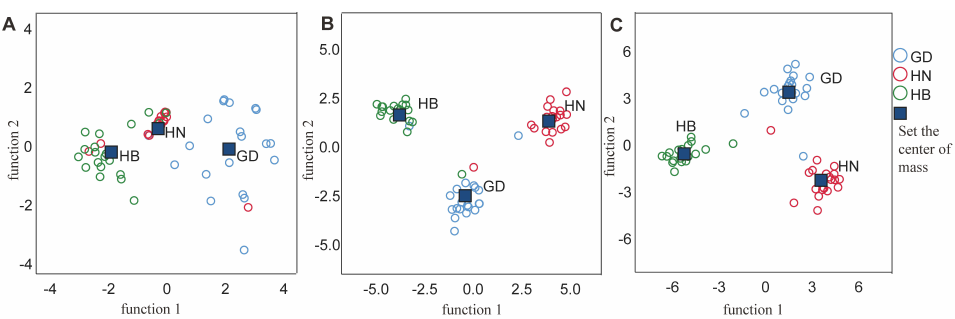
Figure 4. Scatter plots of the linear discriminant analysis of P. clarkii sampled from different re- gions. The scatter plot of δ 13 C and δ 15 N ( A ). The scatter plot of 14 elements ( B ). The scatter plot of 14 elements combined with the stable isotope data ( C ). δ 13 C and δ 15 N represent the stable isotope ratio. GD = Guangdong; HN = Hunan; HB =